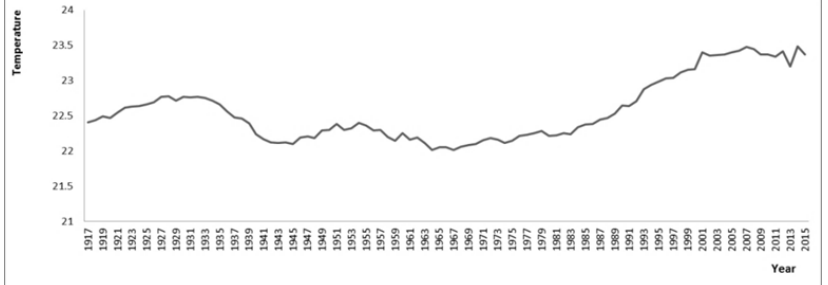
Figure 2. Average Temperatures in Egypt 1917-2015 Source: Climate Change Knowledge Portal World Bank (2018)